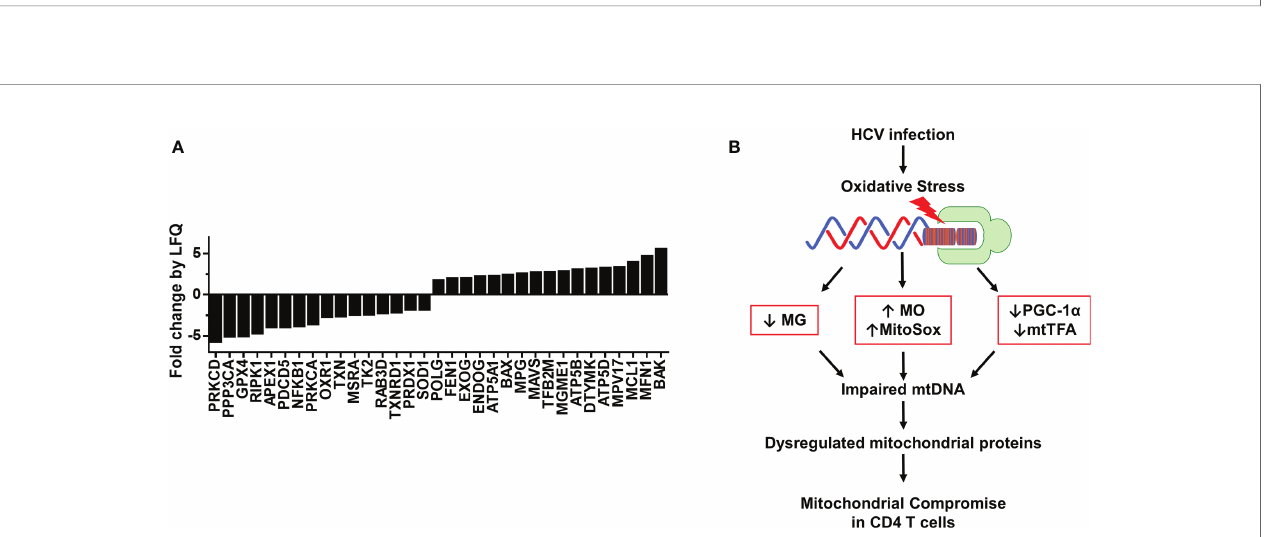
FIGURE 5 | Proteomic analysis of mitochondria from CD4 T cells of HCV-infected individuals and HS. (A) Fold change by quanti fi cation (LFQ) of proteins isolated from mitochondria of HS (n=3) and chronic HCV patients (n=3) was determined by LC-MS proteomic analysis. (B) A model of HCV infection-induced oxidative stress that contributes to the alterations in MG, MO, MitoSOX, PGC-1 a and mtTFA expressions, which further impair mtDNA and contribute to dysregulated mitochondrial proteins, ultimately leading to compromised mitochondrial function in CD4 T cells during chronic viral